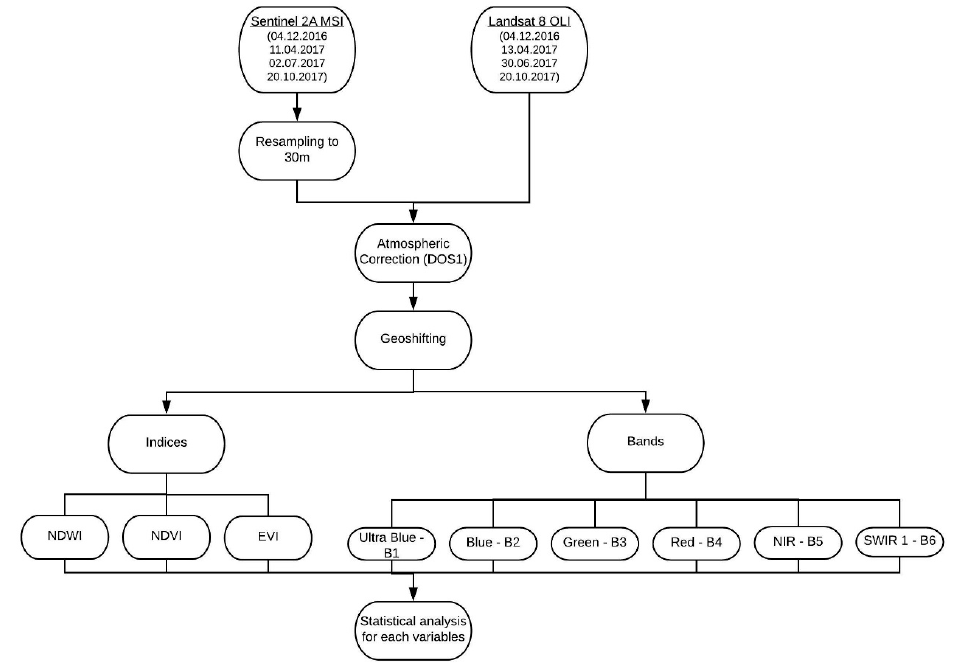
Figure 2. Flowchart of the study.